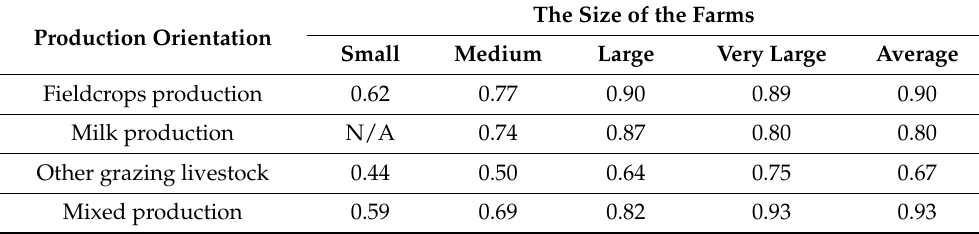
Table 5. Total factor productivity (2015–2020